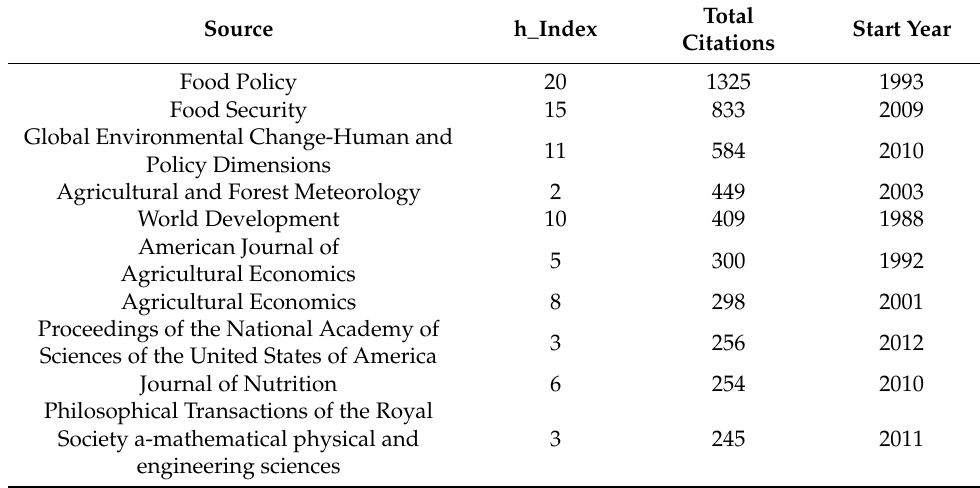
Table 3. Journals’classification based on their